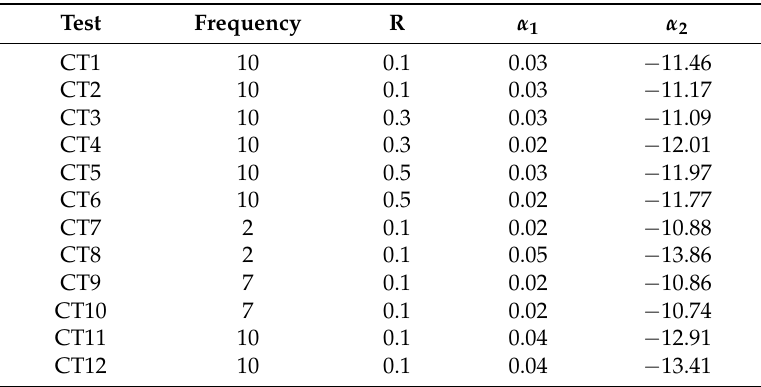
Table 2. Regression parameters for individual test data, Al7075-T6.